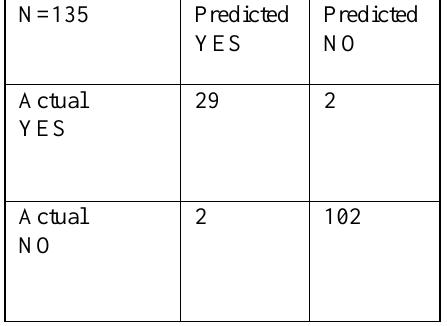
Fig 10 : Error Histogram The total number of observations in each cell is displayed in a confusion matrix. The actual Yes and No is represented by the rows in the matrix while the column indicates the Predicted Yes or No. The correct and incorrect observations are observed in the diagonal and off-diagonal cells,respectively. Out of the data provided, it is observed that we obtained a predicted YES of 29. Table 1 : Confusion Matrix for our data N=135 Predicted YES